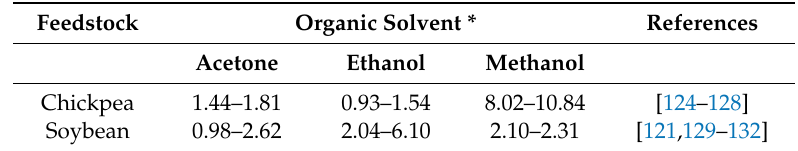
Table 2. Total phenolic contents (mg GAE / g) of chickpea and